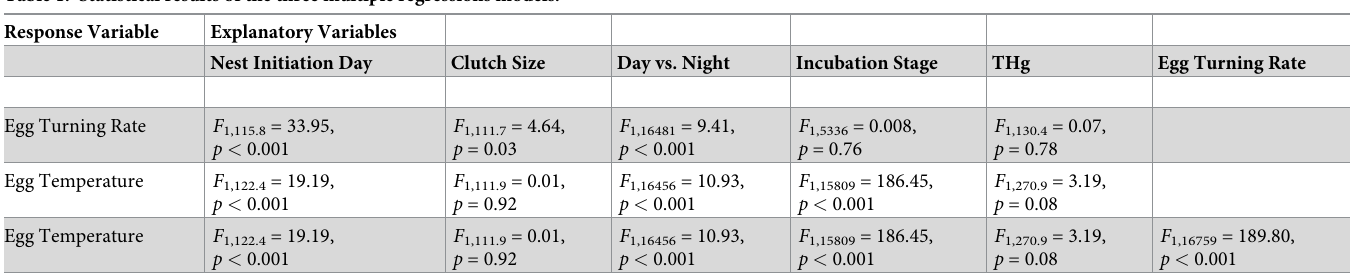
Table 1. Statistical results of the three multiple regressions models.